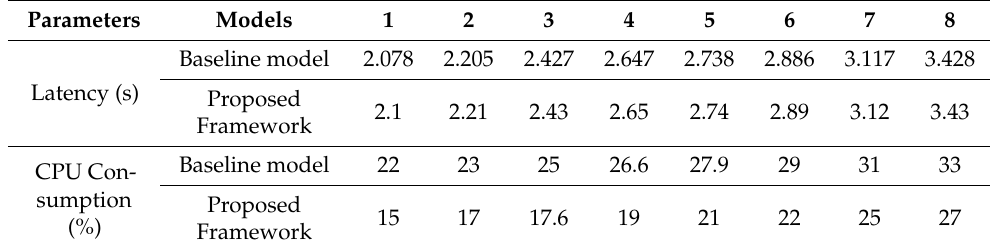
Table 5. Analysis of Prof DT in Latency and CPU